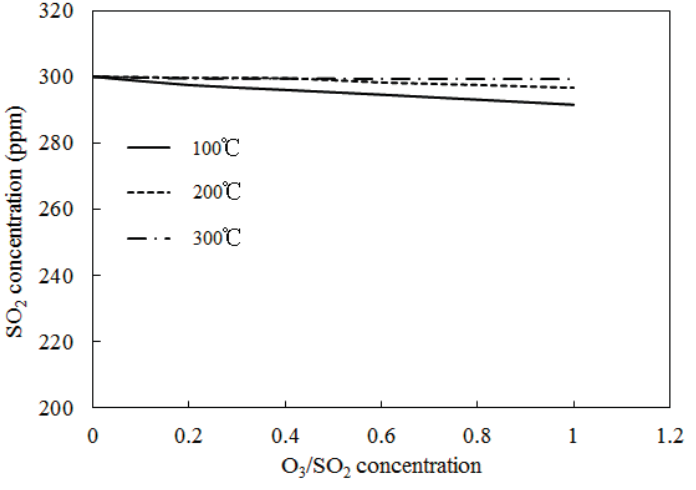
Figure 13. Variations of SO 2 concentrations with O 3 /SO 2 mole fractions at different